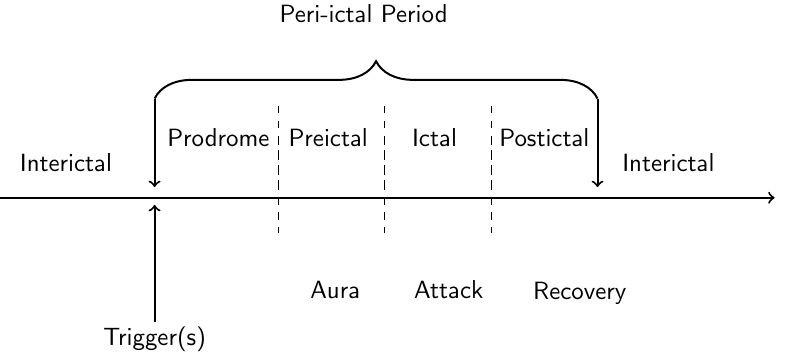
Figure 1. Time course of the stages of